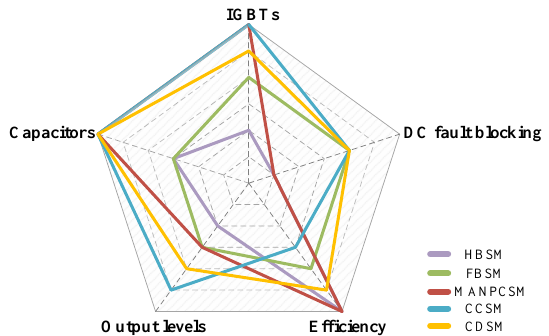
Figure 20. Qualitative comparison of selected submodules for the Modular Multilevel